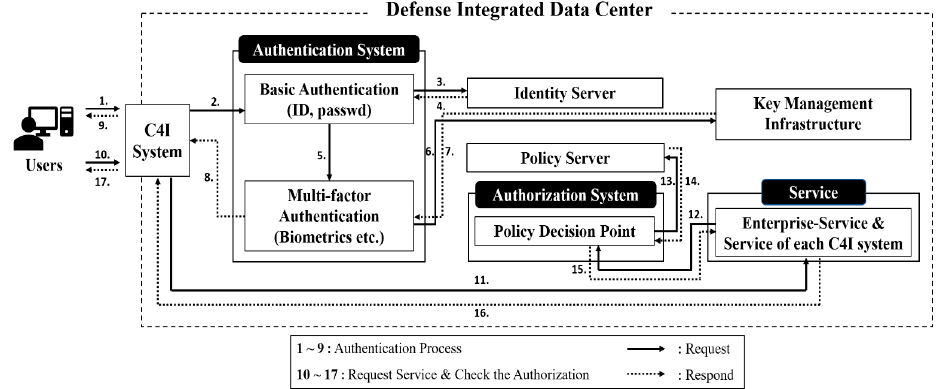
Figure 5. Authentication and Access Control for Cloud-based C4I System.